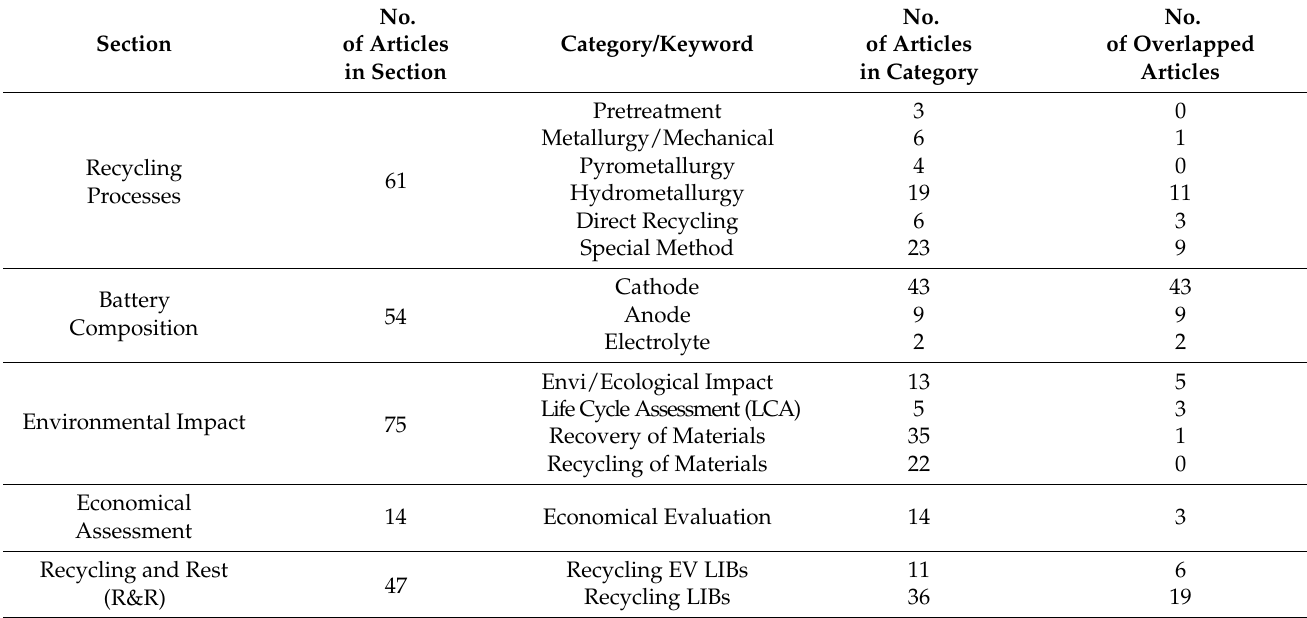
Table 1. Distribution of publications; the methodology of performed literature review.